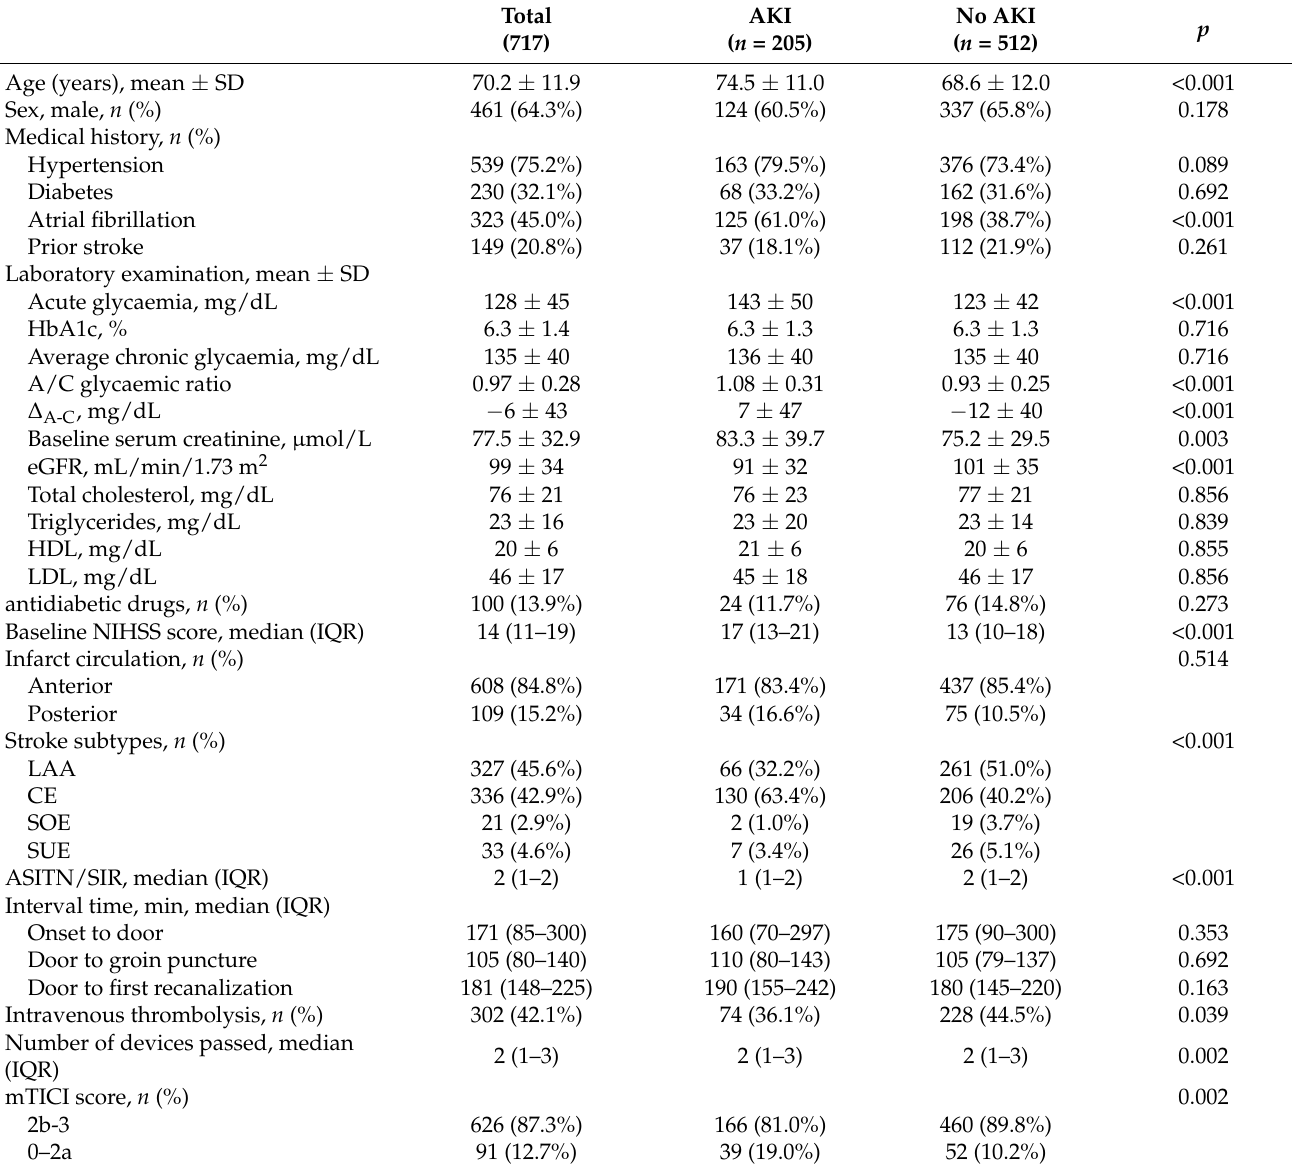
Table 1. Baseline characteristics of patients with and without